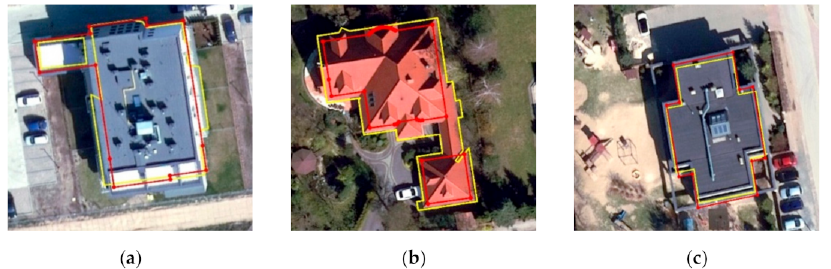
Figure 12. Building outlines: yellow from LiDAR, red from the cadastre: ( a ) multi-family building extracted as two building outlines; ( b ) two connected single-family houses denoted by LiDAR as one building; ( c ) outlines of a